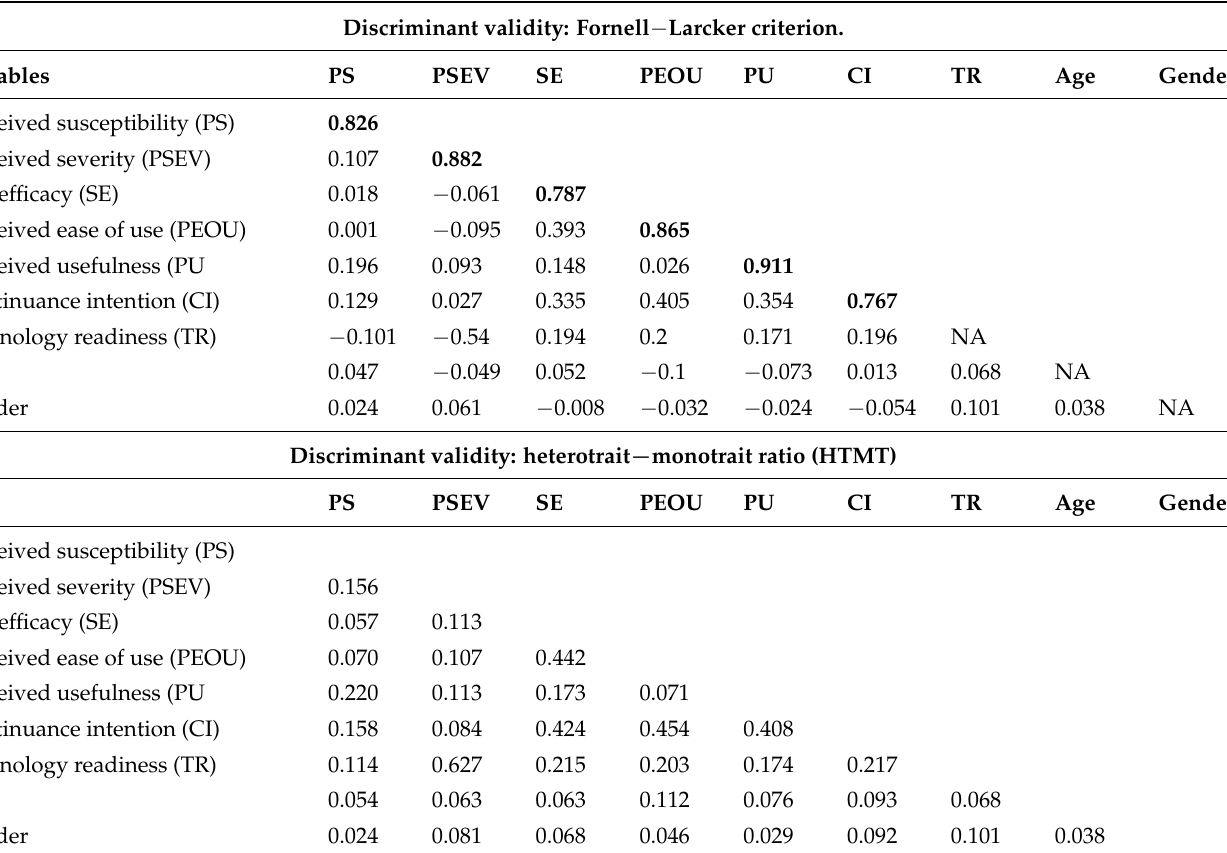
Table 3. Measurement model evaluation: discriminant